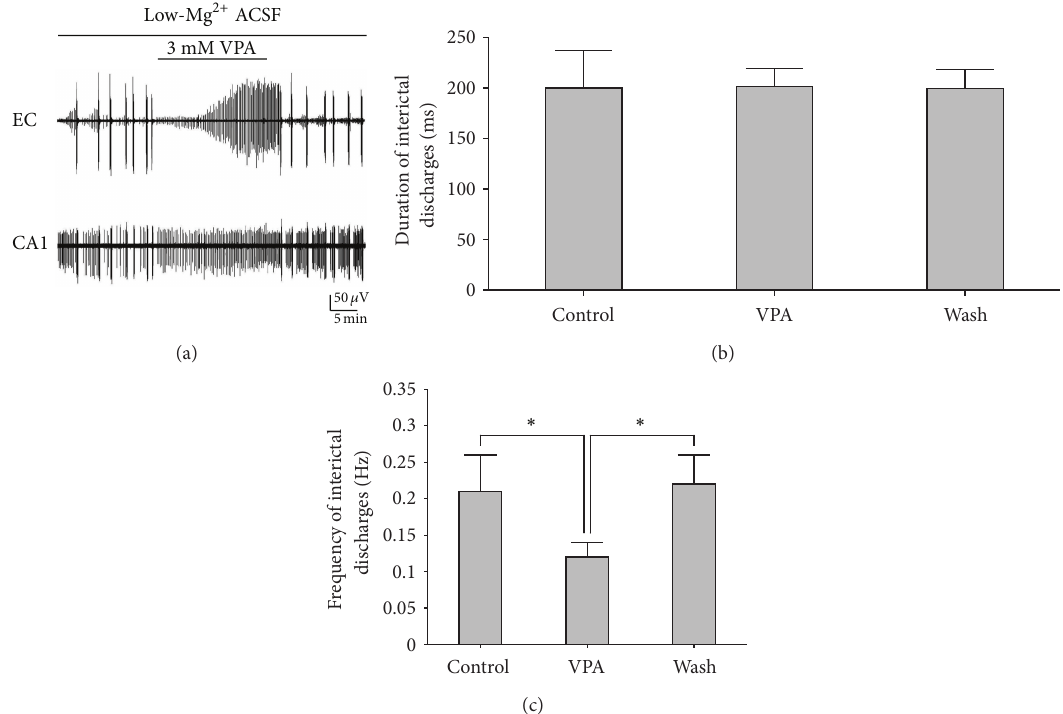
Figure 9: Effects of VPA on the epileptiform discharges in the EC and CA1 areas of the combined slices. (a) Long-term display of the effects of VPA (before, during, and after VPA application) on the discharge patterns in the EC and CA1 areas of an example of a combined slice. (b) The statistical analysis of VPA effects on duration of interictal discharges in CA1. There were no significant differences between the VPA group and the Control/Wash ( 𝑃 > 0.05 , ANOVA, 𝑛 = 5 ). (c) The statistical analysis of VPA effects on frequency of interictal discharges in the CA1. There were significant differences between the VPA group and the Control/Wash ( ∗ 𝑃 < 0.05 , ANOVA, 𝑛 = 5